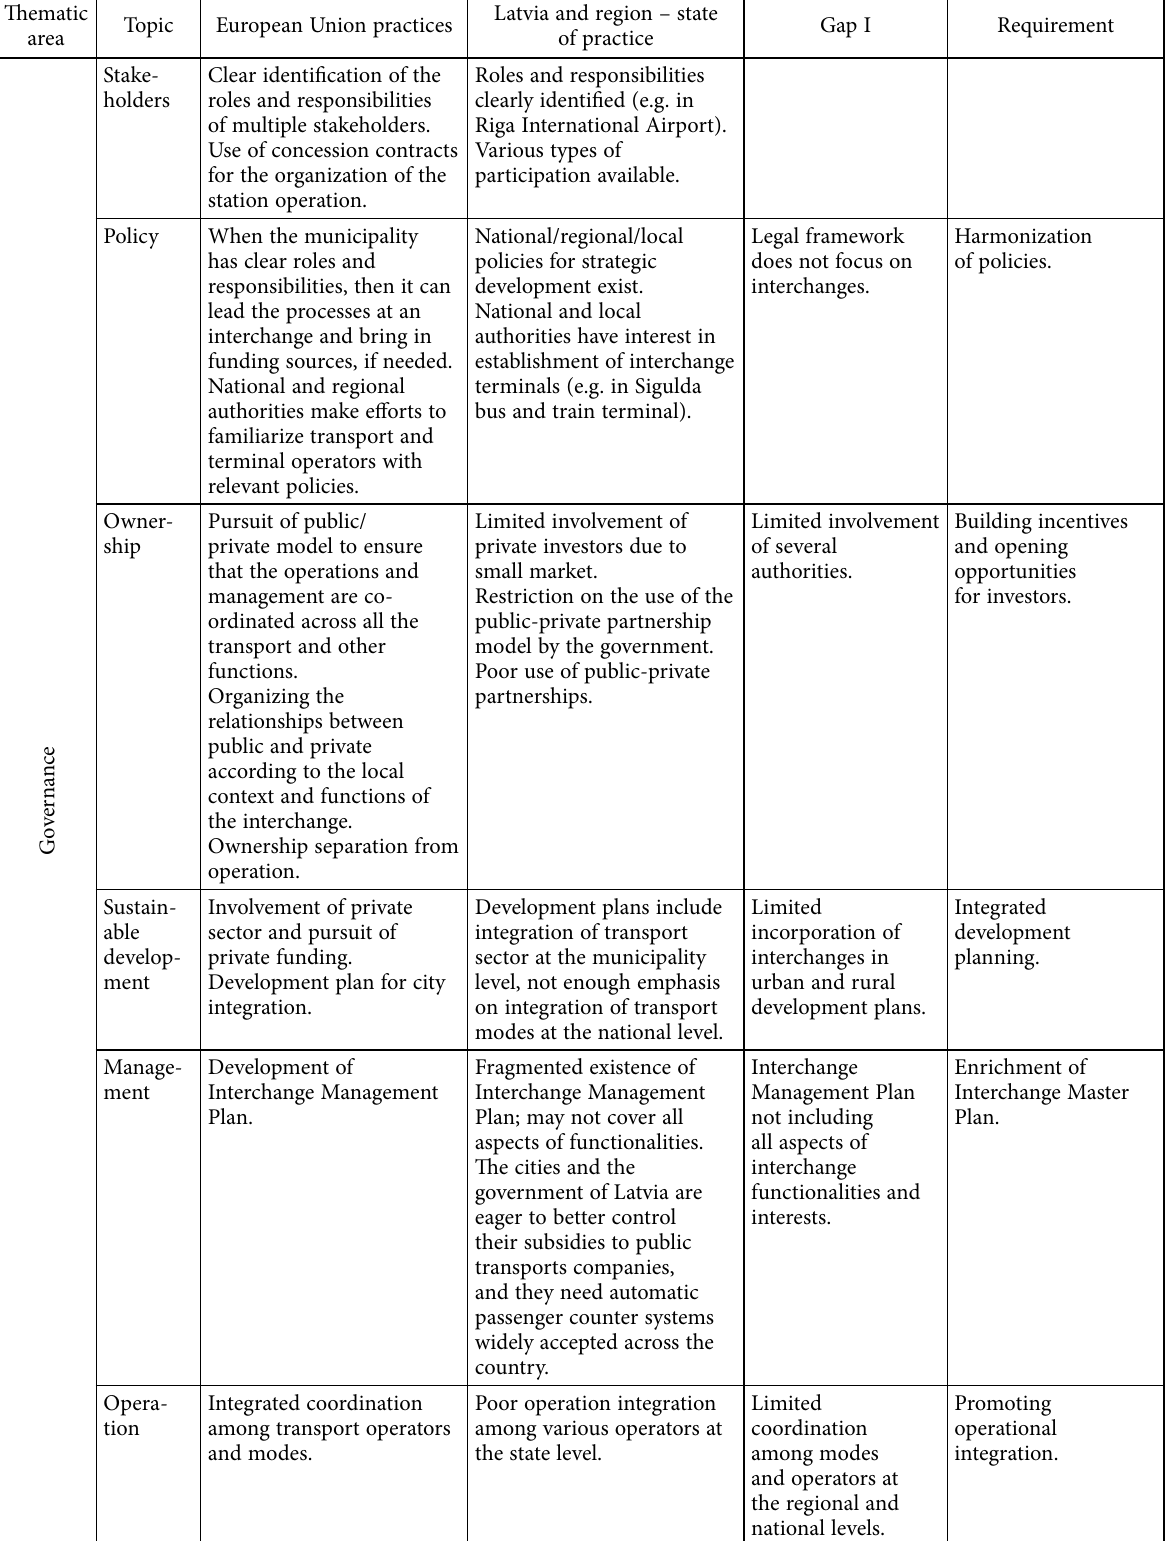
Table 5. Identification of gaps/requirements for passenger